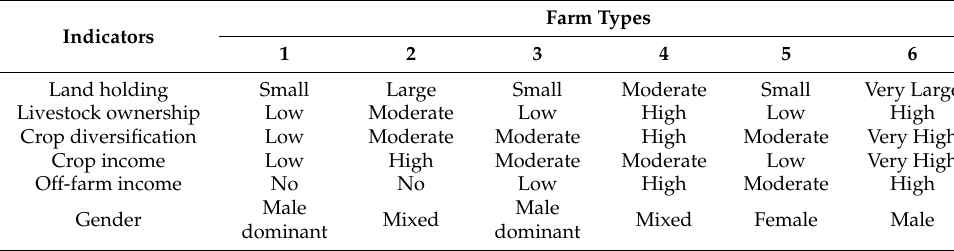
Table 6. Comparison of the six identified farm types to validate the typology.